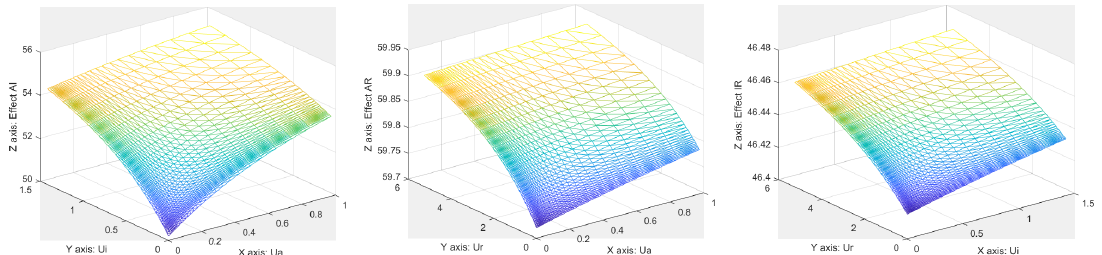
Figure A1. Surface responses obtained for σ = 0.4 for each drug combination.